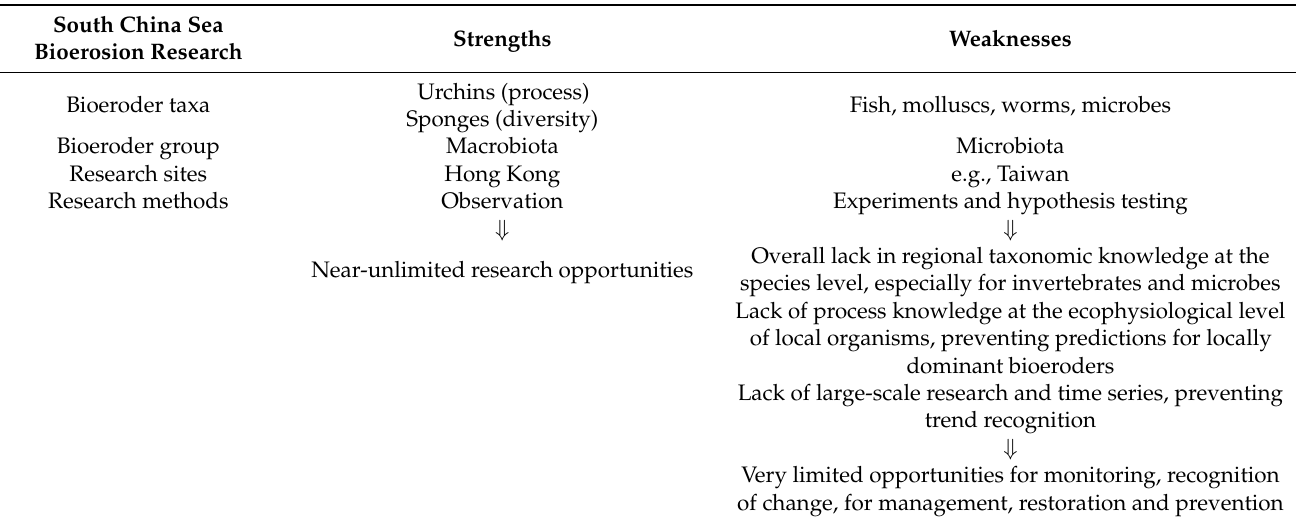
Table 2. Published research on bioerosion research in the South China Sea 1980 to present. Summary of the findings based on our literature analysis (see Supplementary Materials), highlighting bias, gaps and resulting research